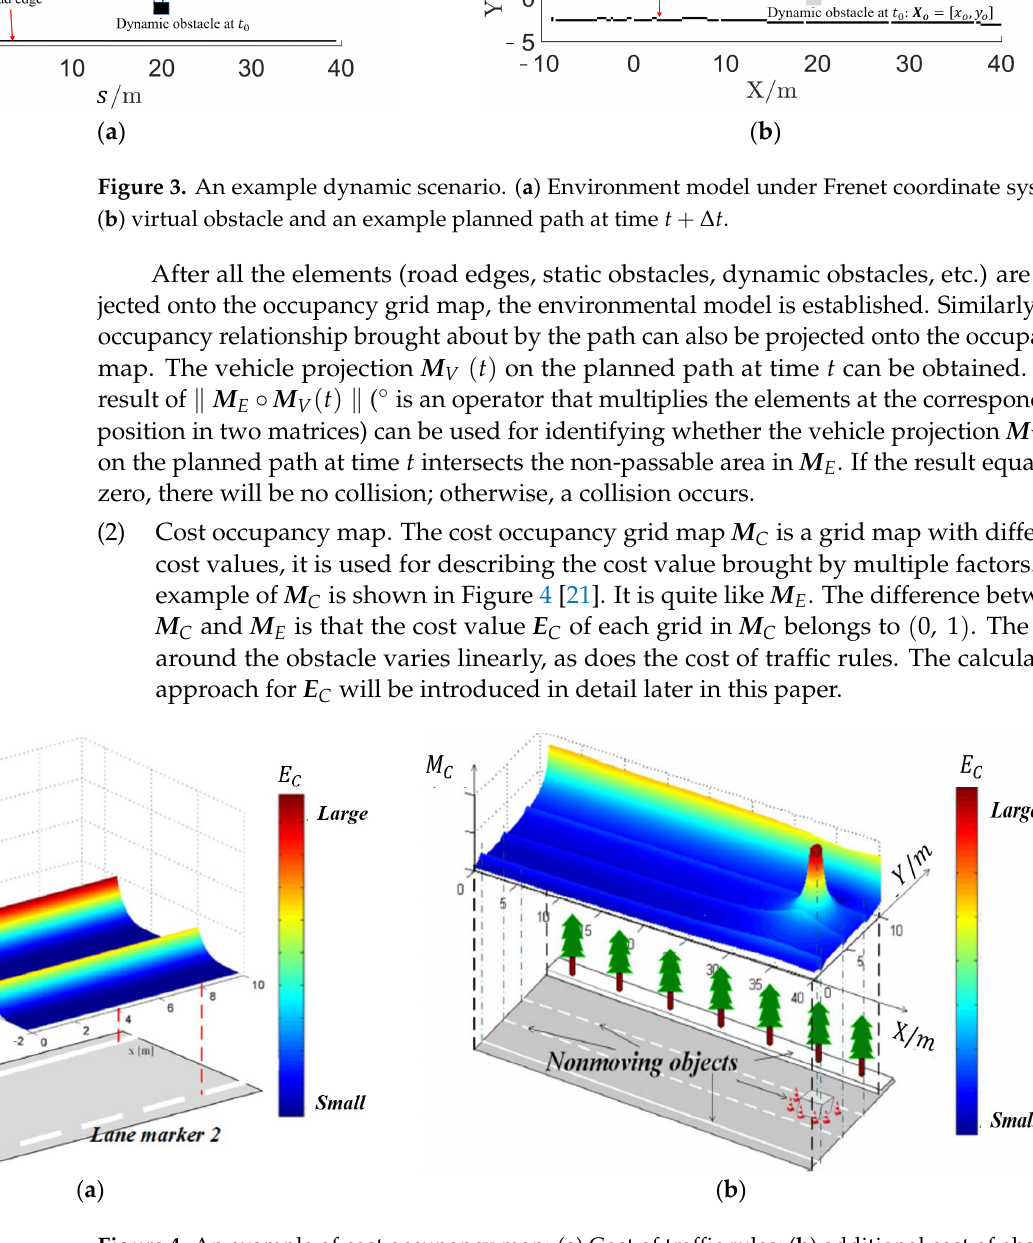
Figure 4. An example of cost occupancy map: ( a ) Cost of traffic rules; ( b ) additional cost of obstacle avoidance